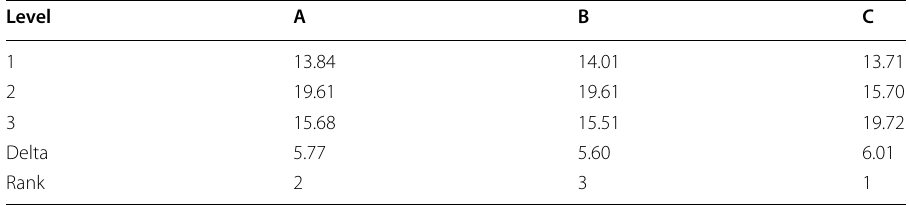
Table 3 Response table for signal-to-noise ratios. Smaller-is-better